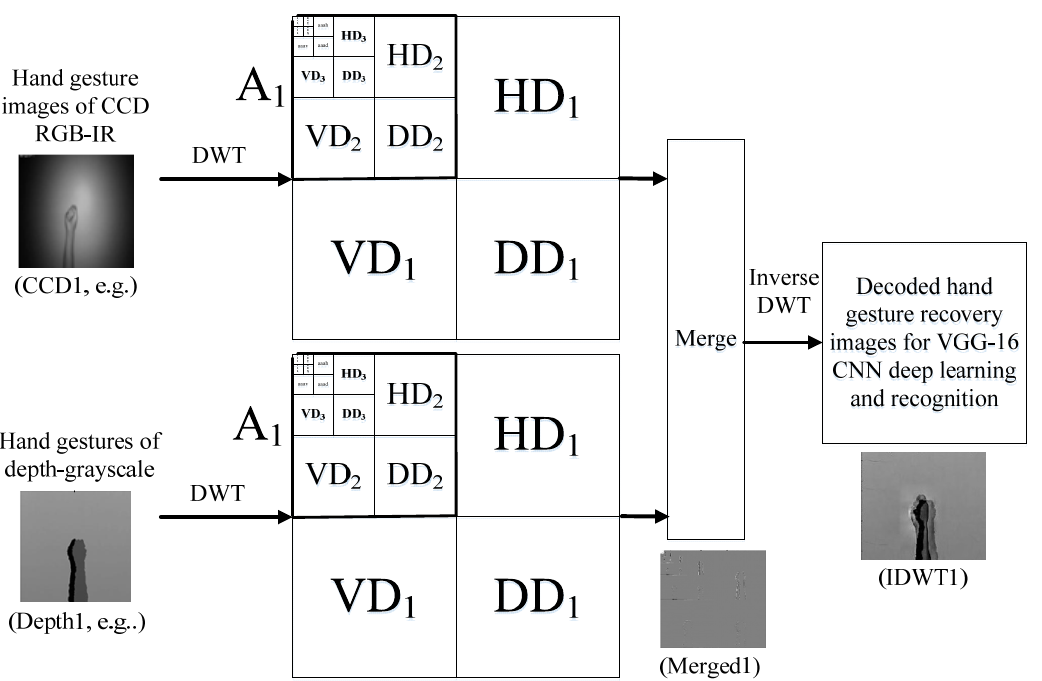
Figure 4. The wavelet transform fused-data stream for VGG-16 CNN deep learning and recogni- tion acquired by DWT decomposition of the input image, DWT filter coefficient merge and inverse DWT to obtain the recovery image.